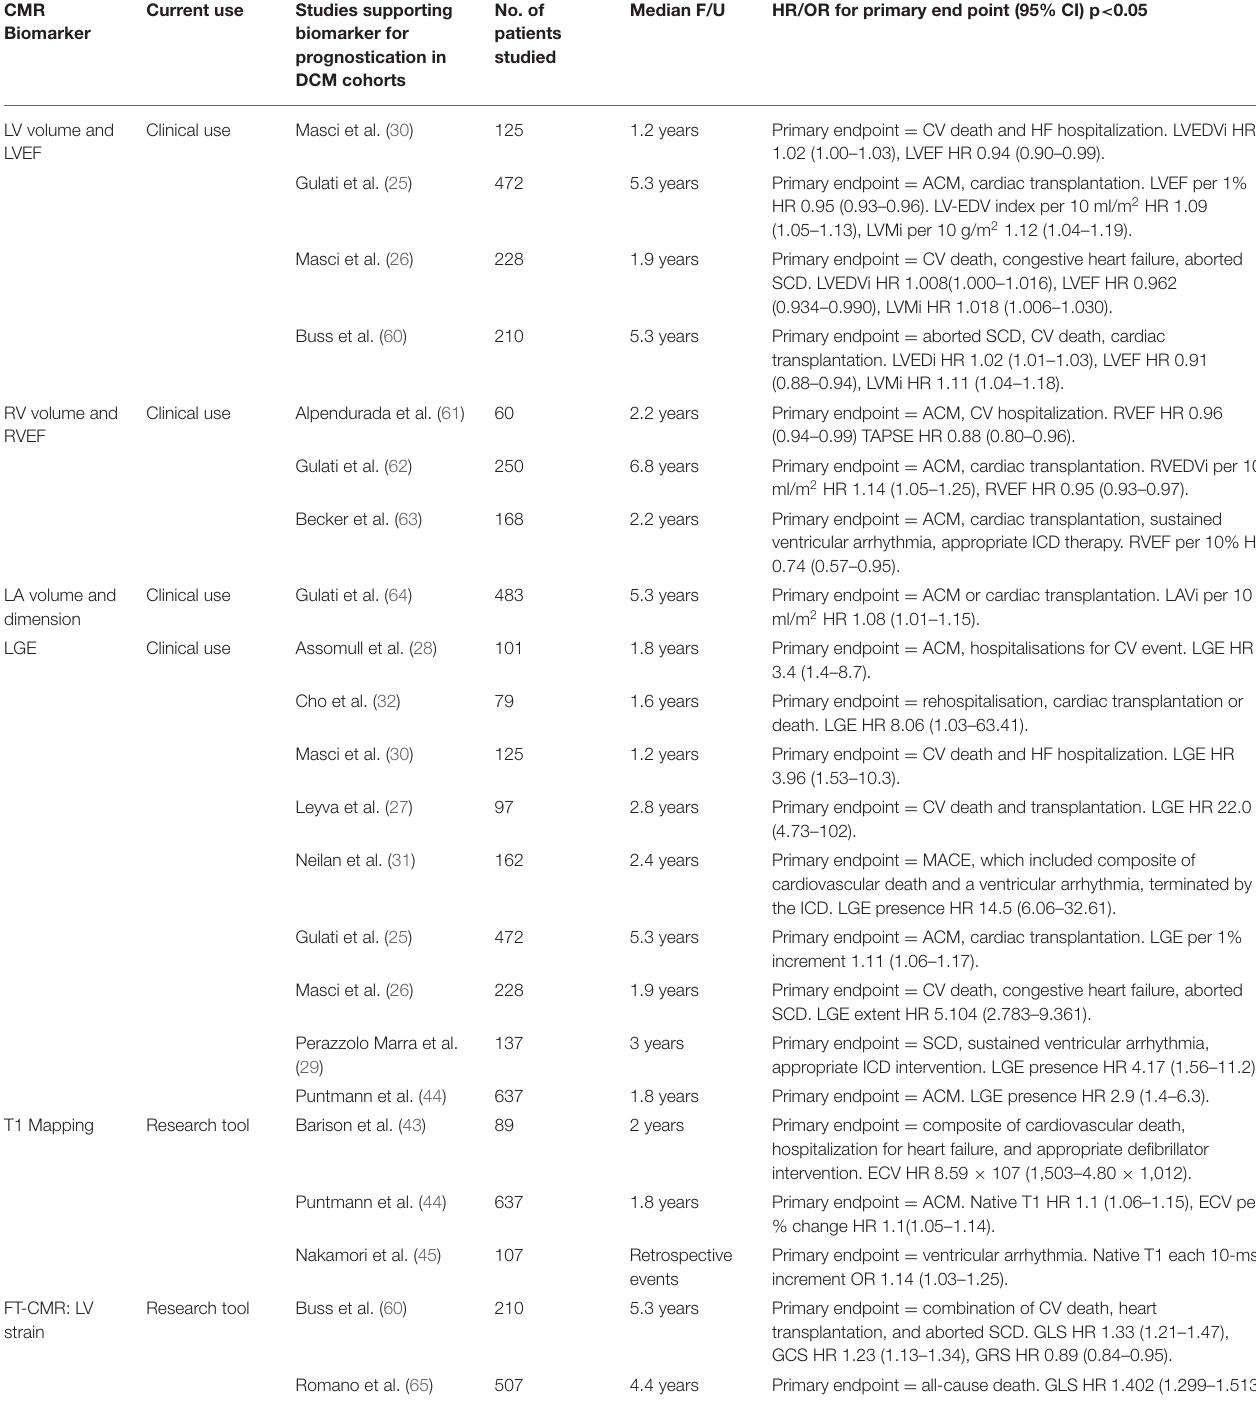
LV, left ventricular; LVEF, left ventricular ejection fraction; HF, heart failure; LVEDVi, indexed left ventricular end diastolic volume; ACM, all-cause mortality; LV-EDV, left ventricular end diastolic volume; LVMi, indexed left ventricular mass; SCD, sudden cardiac death; CV, cardiovascular; RV, right ventricular; RVEF, right ventricular ejection fraction; TAPSE, tricuspid annular plane systolic excursion; RVEDVi, indexed right ventricular end diastolic volume; ICD, implantable cardioverter defibrillator; LA, left atrial; LAVi, indexed left atrial volume; LGE, late gadolinium enhancement; MACE, major adverse cardiac events; ECV, extracellular volume; FT-CMR, feature tracking-cardiac magnetic resonance imaging; GLS, global longitudinal strain; GCS, global circumferential strain; GRS, global radial strain.